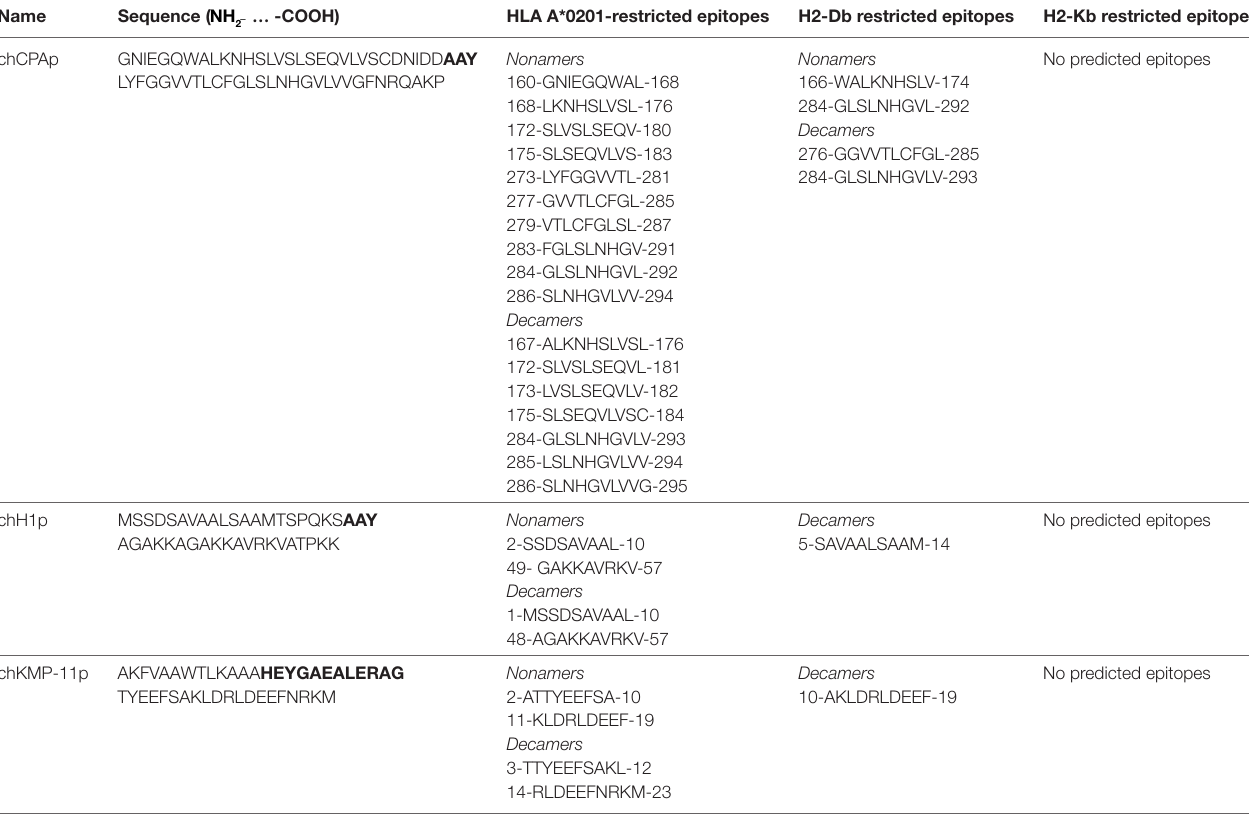
TaBle 2 | HLA A*0201, H2-Db, and H2-Kb restricted epitopes included in the chimeric peptides from the Leishmania infantum immunogenic proteins cysteine peptidase A (CPA), histone H1, and kinetoplastid membrane protein 11 (KMP-11).